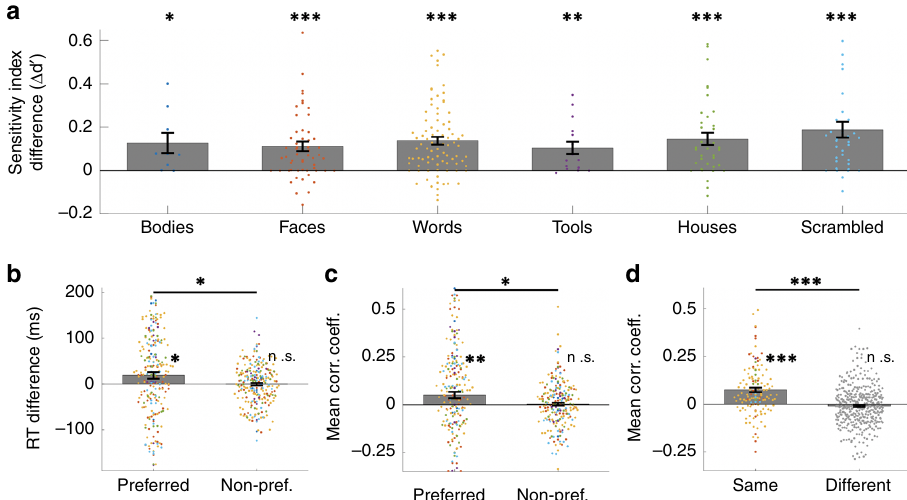
Fig. 2 Pre-stimulus activity modulates post-stimulus tuning and predicts behavior. a Bar plot of the averaged difference in category classi fi cation accuracy (mean sensitivity index difference Δ d ′ ) for each category. Δ d ′ is the accuracy conditioning on pre-stimulus activity (post-stimulus + pre- stimulus) minus the accuracy using only post-stimulus activity (post-stimulus only). Each colored dot represents the results from a single electrode ( n = 9, 56, 92, 16, 37, 36, respectively, for each plot). See Table 1 for detailed paired comparison results for each category. b The difference in reaction time in between high MI trials (top quarter) and low MI trials (bottom quarter) in the preferred condition of the electrode (left) and in the non-preferred condition of the electrode (right). Each colored dot represents the averaged RT difference from one single electrode, 246 samples in total for each bar plot. c The correlation coef fi cients between modulation index (MI) and trial-by-trial reaction times at each electrode for the preferred condition of the electrode (left) and for the non-preferred conditions of the electrode (right). Each colored dot represents the correlation coef fi cient from one single electrode, 246 samples in total for each bar plot. d The correlation coef fi cients (Spearman ’ s rho) for cross-electrode correlation in MI between a pair of electrodes with the same category selectivity (left) versus a pair of electrodes with different category selectivity (right). Each colored dot represents the correlation between a pair of electrodes. Data are presented as mean values ± s.e.m.; * p < 0.05, ** p < 0.01, *** p < 0.001, n.s . p > 0.1, two-sided paired t -test for ( a ) and ( c ), permutation Fig. 1b. (Source data are provided as a Source Data fi